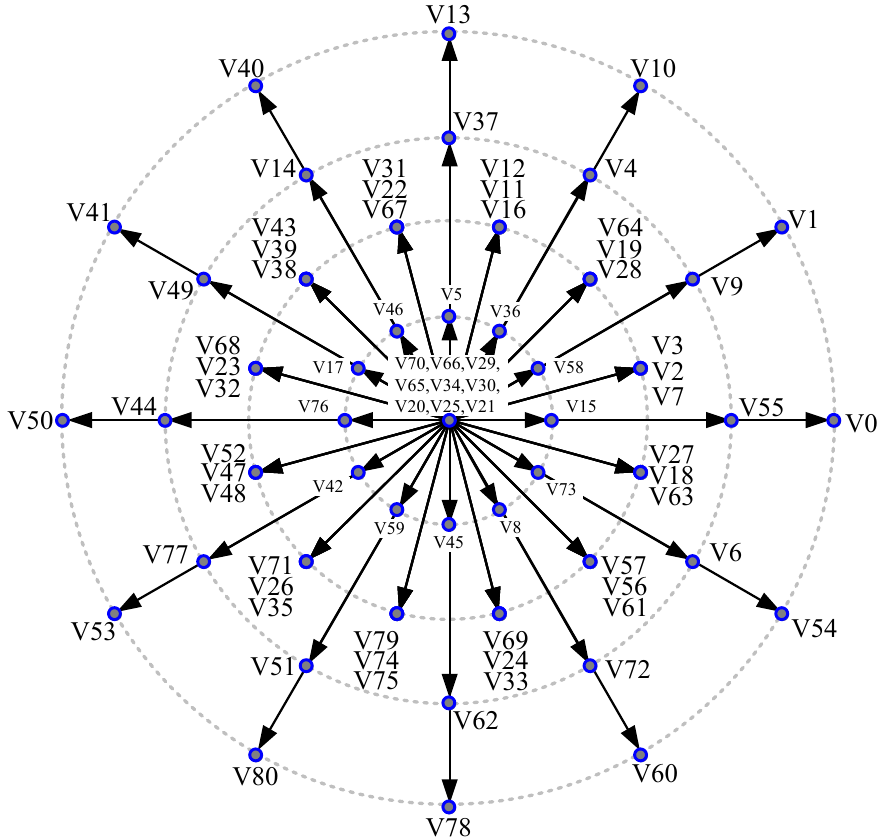
Figure 8. The space-vector diagram for S MC p switch